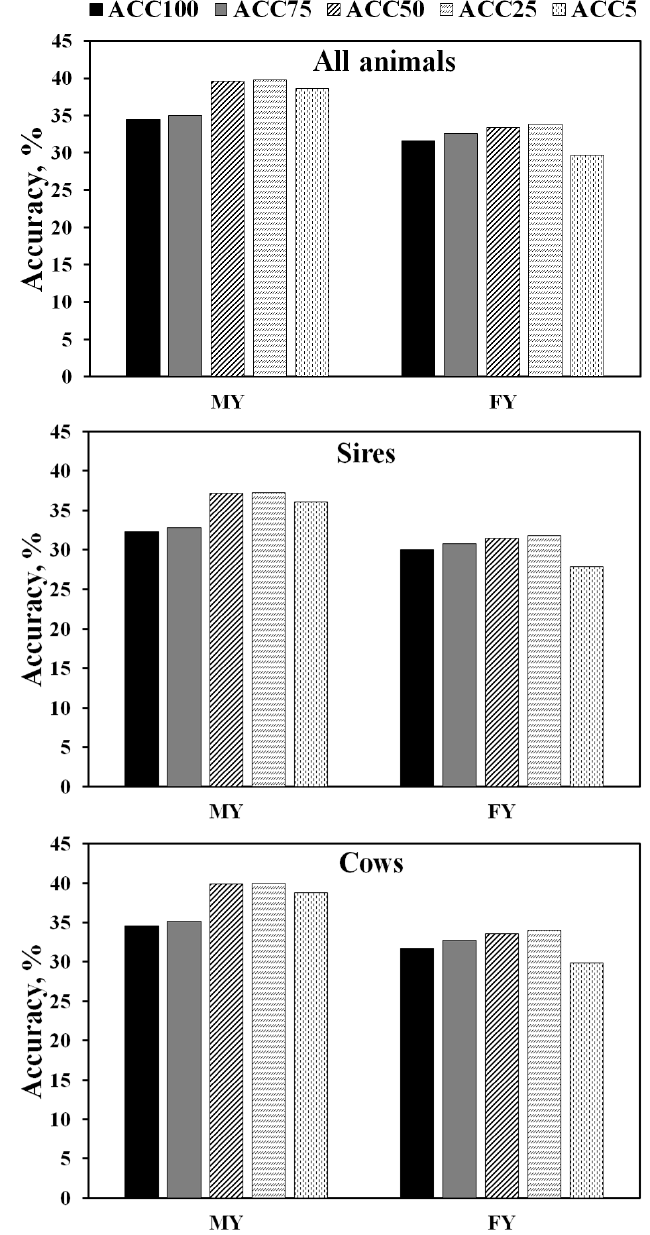
Figure 1. Accuracy of estimated breeding value for MY and FY estimated with five single nucleotide polymorphism sets using genomic-polygenic models. MY, milk yield; FY, fat